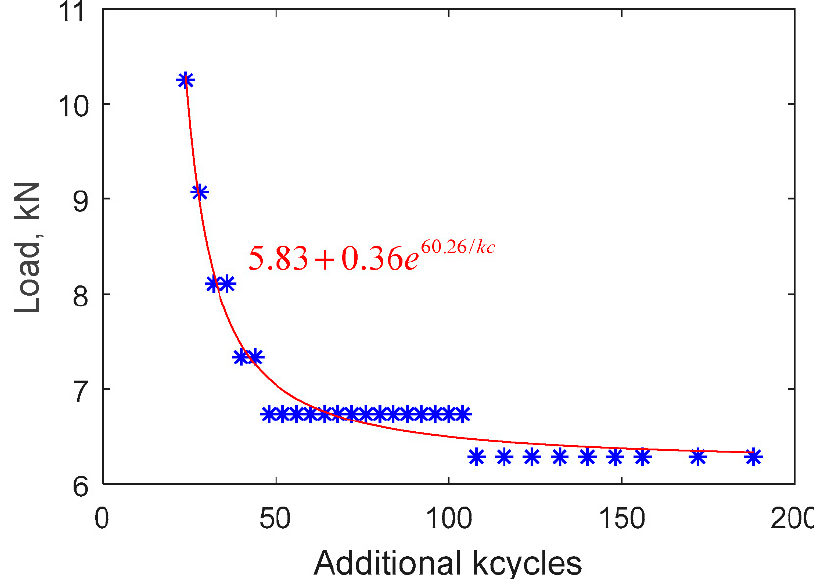
Figure 11. The load adjustment history with fatigue cycles.